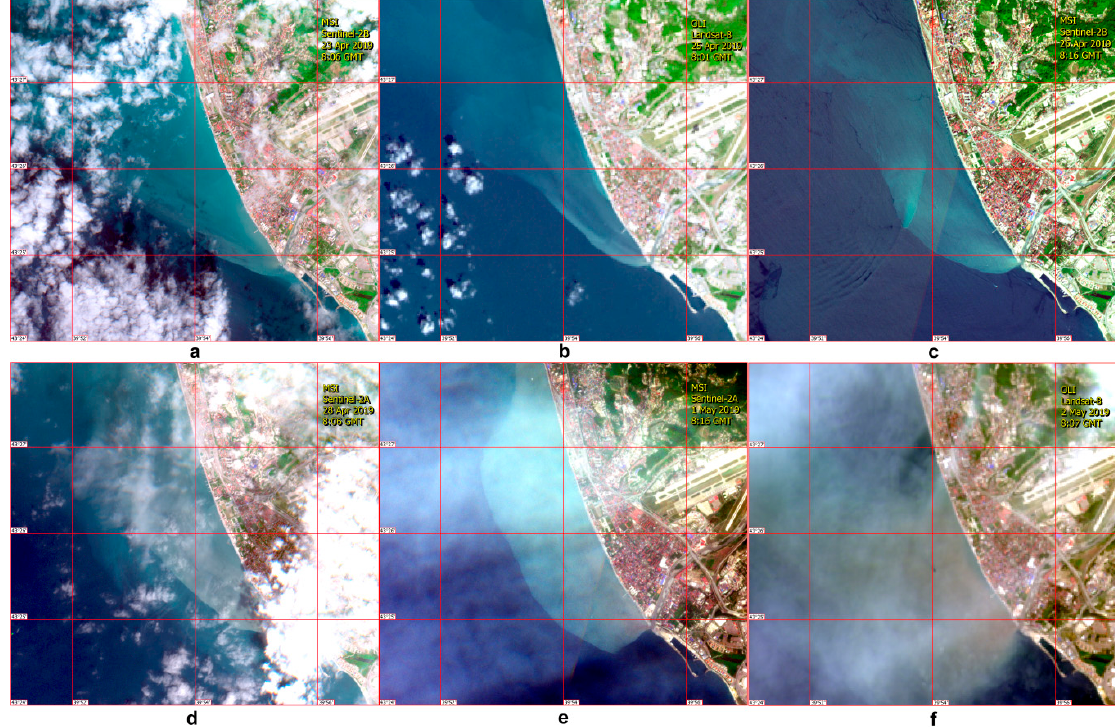
Figure 8. Fragments of satellite images obtained during the measurement period: 23 April 2019, Sentinel-2B Multispectral Instrument (MSI) ( a ); 25 April 2019, Landsat-8 Operational Land Imager (OLI) ( b ); 26 April 2019, Sentinel-2B MSI ( c ); 28 April 2019, Sentinel-2A MSI ( d ); 1 May 2019, Sentinel-2A MSI ( e ); 2 May 2019, Landsat-8 OLI ( f ). Table 5. Satellite information available during field measurements.